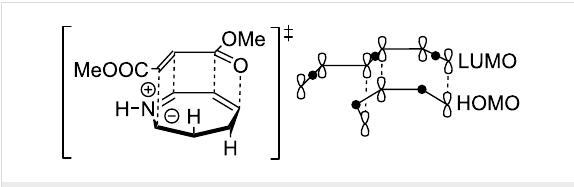
Figure 3: Selective formation of a single diastereomer in the 1,3- dipolar cycloaddition reaction.